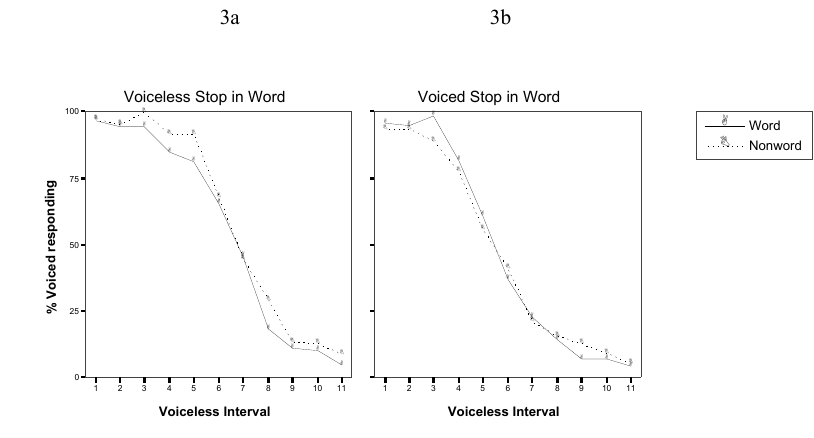
Figure 3: Results of Experiment 2. Mean percentages of voiced responses for the 6 word- -nonword continua for which an advantage for voiceless responding was expected for words and corresponding nonword-nonword controls (left) and for the 6 ones for which an advantage for voiced responding was expected for words and corresponding nonword- -nonword controls (right). Responses for word-nonword continua are indicated in continuous lines, those for nonword-nonword controls are indicated in broken